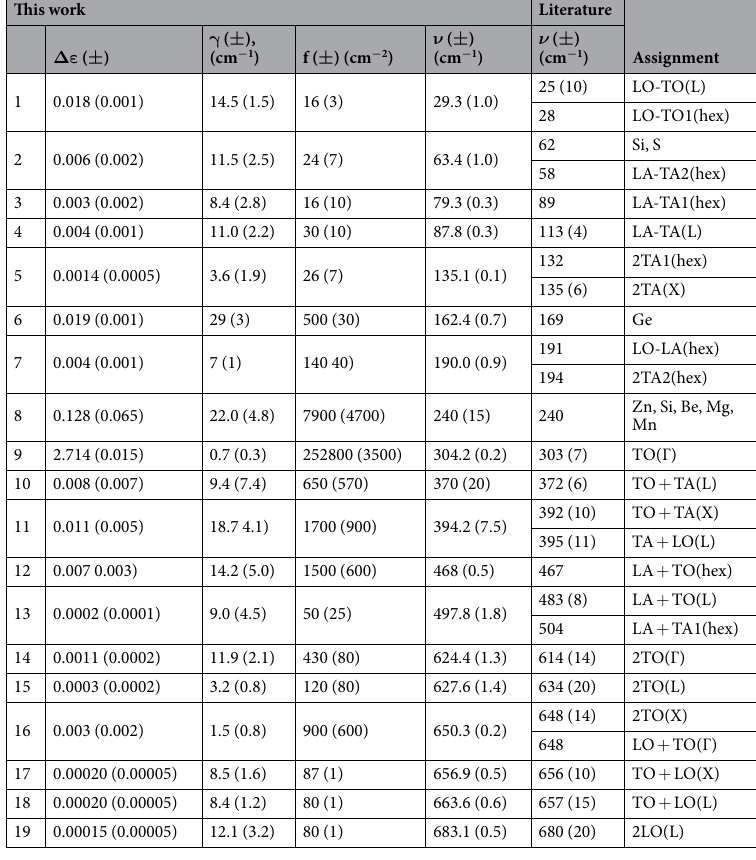
Table 1. Parameters of the absorption lines (Eq. (1) in the text) identified in the dielectric data from the SI InP crystals. The notations in the table are as follows: Δε – dielectric strength, γ – damping, f – oscillator strength, ν - resonance frequency. The “Literature” and “Assignment” columns refer to the literature values of the resonance frequencies and our assignment based on the literature. Phonon coupling assignments are done according to Koteles 26 . The designations in brackets refer to phonon branches locations: “hex” refers to a location on the (111) hexagonal face of the Brillouin zone boundary in accordance with 26 , Γ is the center of the Brilloiun zone (000), L is the center of the hexagonal face in the (111) wavevector direction, and X is the center of the cubic face in the (100) wavevector direction. Impurity assignments are done according to refs 23,